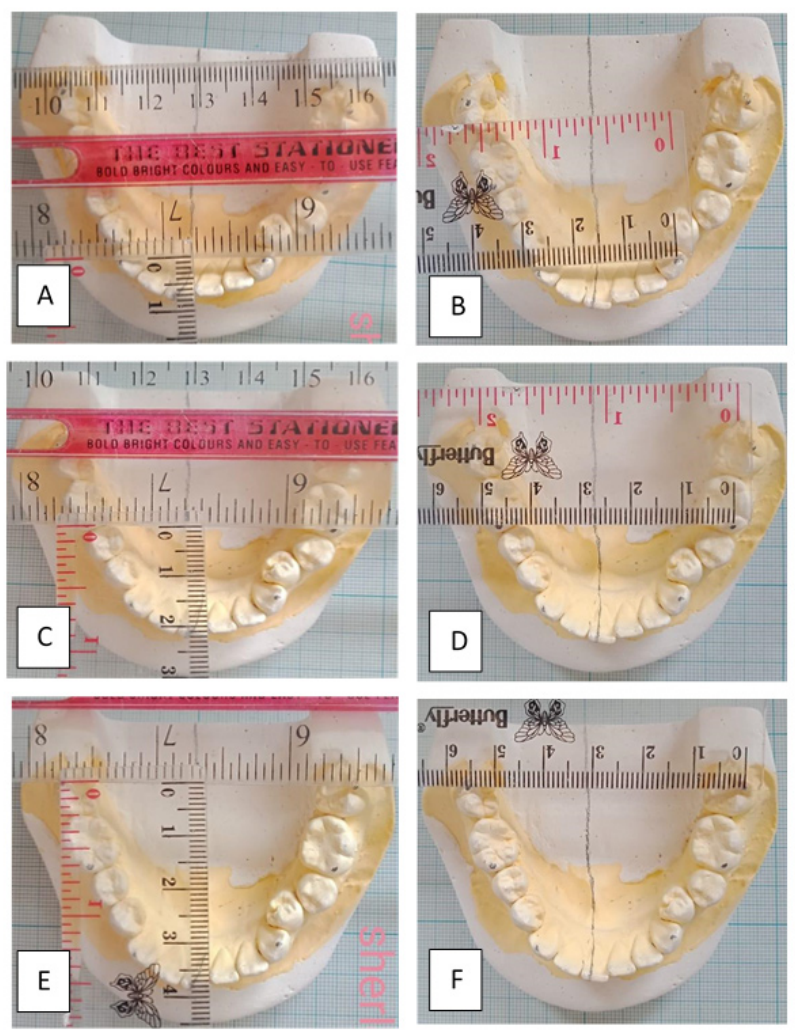
Figure 5. Measurement of lower dental arch form. The sagittal dental arch from the arrow of the anterior curve (L31) ( A ); from right canine cusp to left canine cusp is identified as intercanine width (L33) ( B ); the incisal edge to the line joining the mesiobuccal canines of the first molar (L61) ( C ); the dental arch dimension from right first molar cusp to the left first molar cusp is intermolar width (L66) ( D ); the incisal edge to the line joining the distobuccal cusp of the second molar (L71) ( E ); from right second molar cusp to the left second molar cusp is the posterior intermolar width (L77) ( F